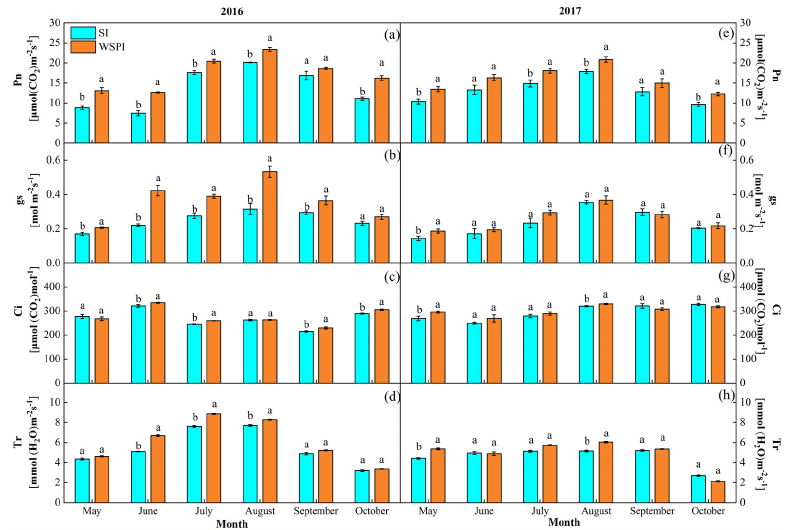
Figure 5. Net photosynthesis rate (Pn), stomatal conductance (gs), intercellular CO 2 concentration (Ci), and transpiration rate (Tr) of apple leaves under water storage pit irrigation (WSPI) and surface irrigation (SI) in 2016 ( a – d ) and 2017( e – h ). Bars indicate standard errors of the mean ( n = 9); the same letters in figure indicate nonsignificant differences between the treatments, whereas different letters show significant differences ( p < 0.05).